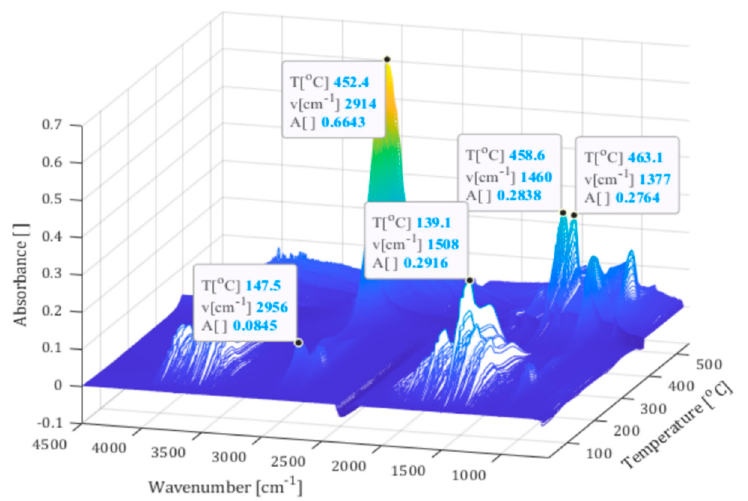
Figure 3. Results of the TGA-FTIR analysis for the PP film former solution.